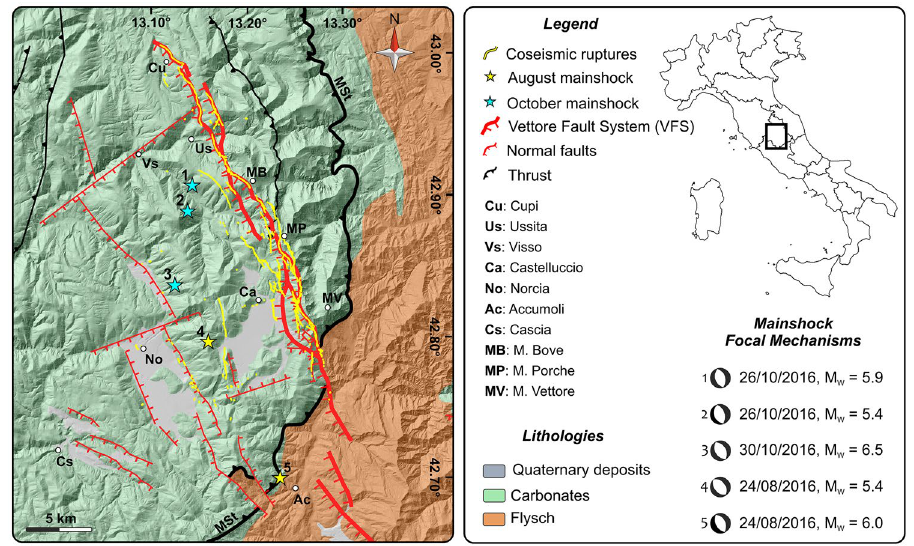
Figure 1. Geological map. Geological scheme of the study area (modified after 22 ) and coseismic ruptures observed in the field along with the main shocks of the 2016–2017 earthquake sequence.